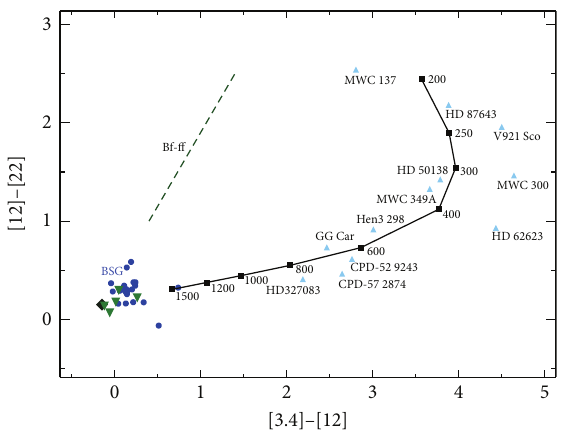
Figure 1: WISE mid-IR colour-colour diagram for galactic BSGs. The full lines are the colours produced by the simple addition of two blackbodies representing the star (of 20000 K) and the dust (with a variety of temperatures as indicated) for a constant 𝐿 The sgB[e] candidates (blue triangles [9]) and regular BSGs (blue dots) are indicated from the sample studied by Crowther et al. [20]. The colours for stars with excess bf-ff emission were determined empirically. Green triangles are 𝛼 Cyg variables, namely, HD 64760, HD 163899, HD 46769, HD 152249, and HD